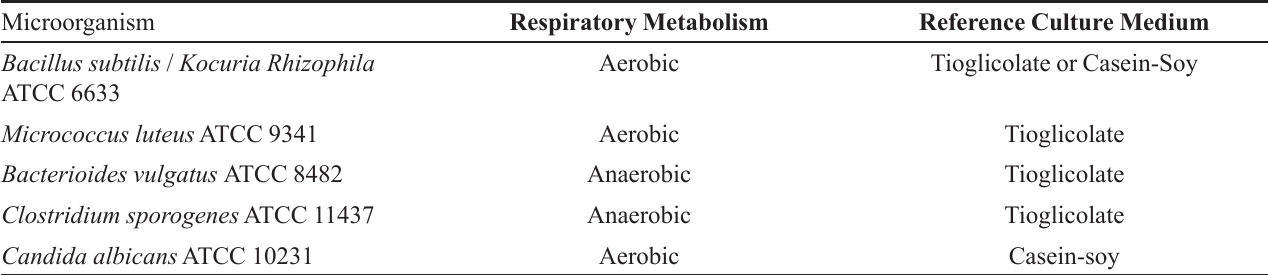
TABLE VIII - Reference strains used in culture medium